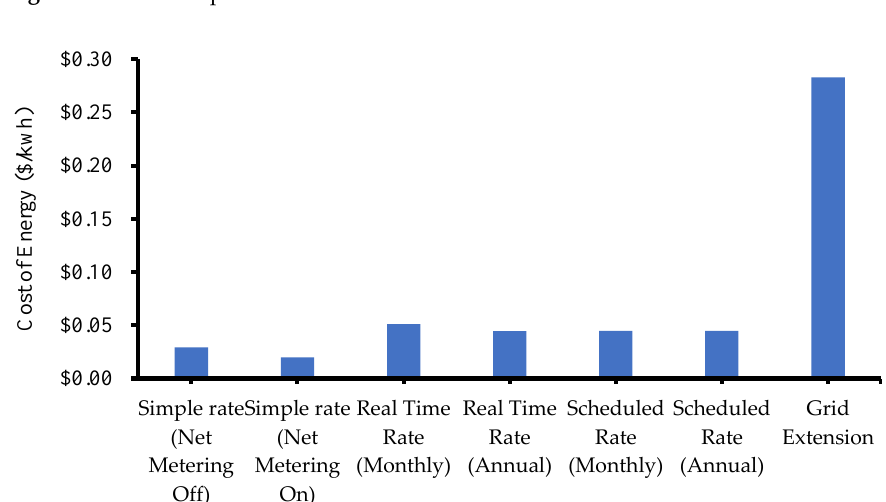
Figure 11. COE Figure 11. COE comparison.